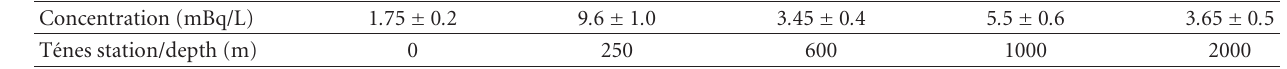
Table 3: Concentration of 90 Sr along seawater column of T´enes station, 2001.